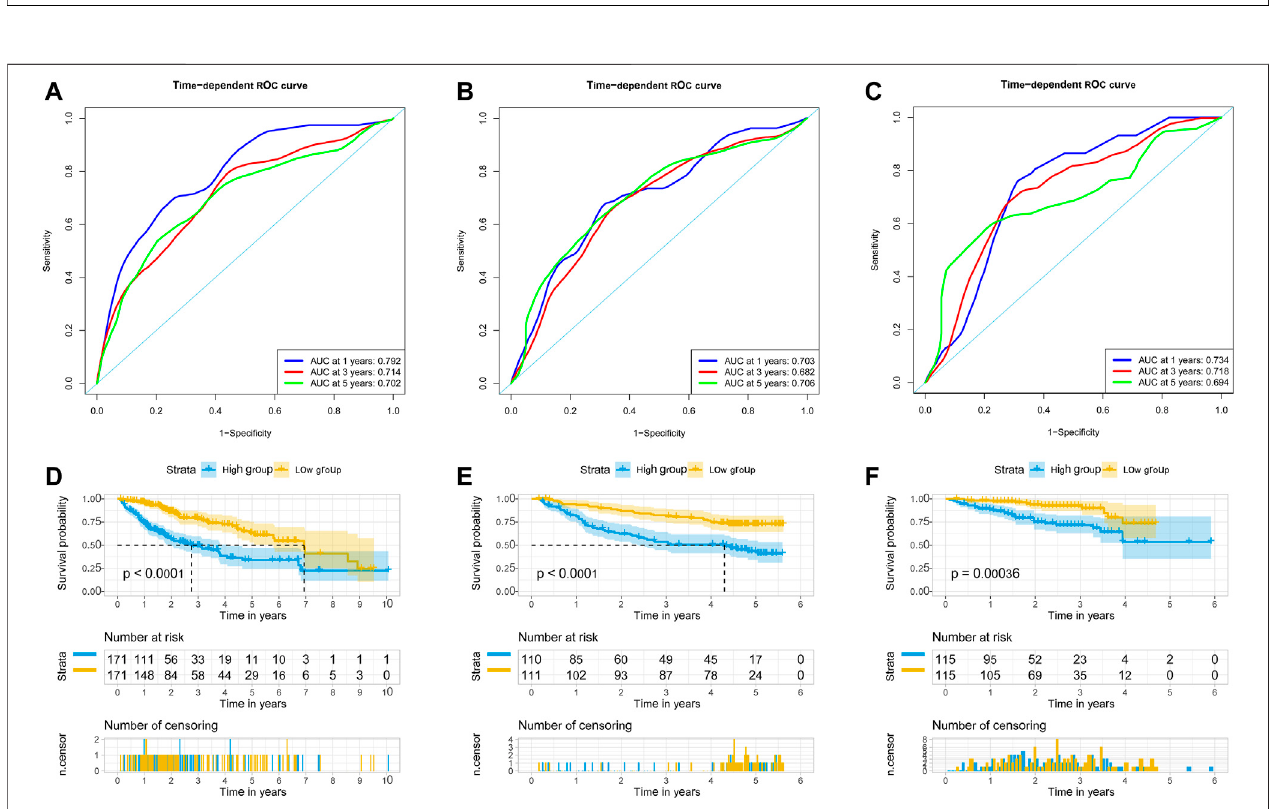
FIGURE5| EMT-correlated genesignature associatedwith HCCpatient ’ soverall survival. (A) . Thepredictive value ofEMTriskscore forpredicting theOSofHCC patientsinTCGAdataset. (B) .ThepredictivevalueofEMTriskscoreforpredictingtheOSofHCCpatientsintheGSE14520dataset. (C) .ThepredictivevalueofEMTrisk score for predicting the OS of HCC patients in ICGC dataset. (D) . The overall survival between the high EMT risk score group and the low EMT risk score group in the TCGA HCC cohort. (E) . The overall survival between the high EMT risk score and the low EMT risk score group in the GSE14520 HCC cohort. (F) . The overall survival between the high EMT risk score and the low EMT risk score group in the ICGC HCC cohort. Notes: HCC, hepatocellular carcinoma; EMT, Epithelial- mesenchymal transition; OS, overall survival; TCGA, The Cancer Genome Atlas Program; ICGC, International Cancer Genome Consortium.